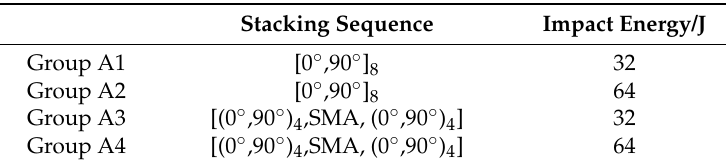
Table 2. The experimental